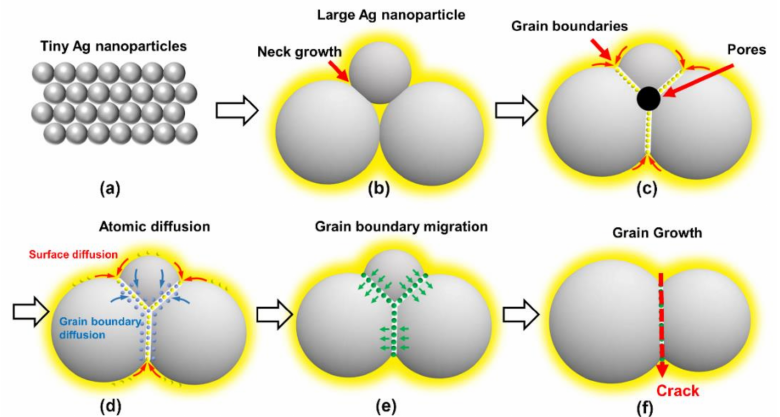
Figure 10. Schematic diagram of grain growth mechanism in surface of sintered structure. ( a ) the original morphology of Ag agglomerate, ( b ) formation of Ag nanoparticles with different sizes, ( c ) formation of pores at the position of triple junctions, ( d ) elimination of pores by surface diffusion and grain boundary diffusion, ( e ) movement of atoms from small size grain to large size grain by grain boundary migration, and ( f ) larger vacancies concentration and lower strength of grain boundary during further grain